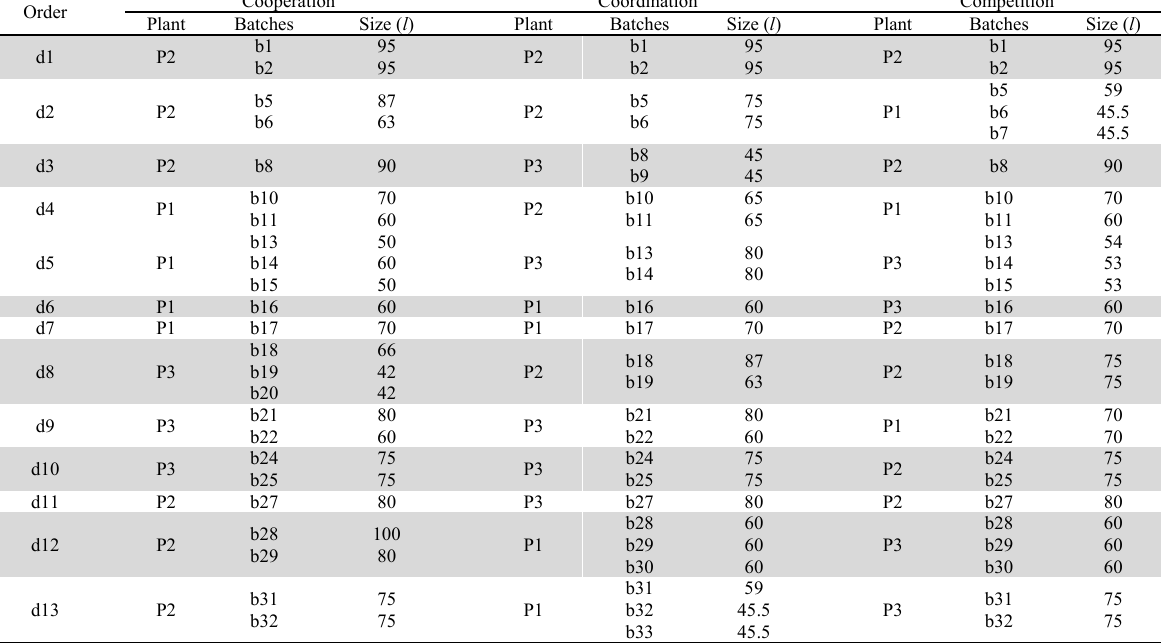
Selected plant and batch sizes for each order and each operational policy at Example 2 Cooperation Order